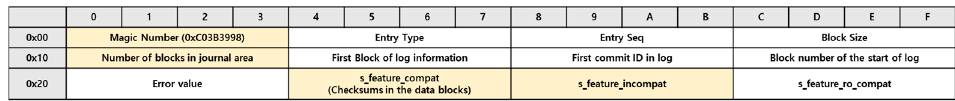
Figure 2. Journal superblock and journal block header of Ext4 file system.